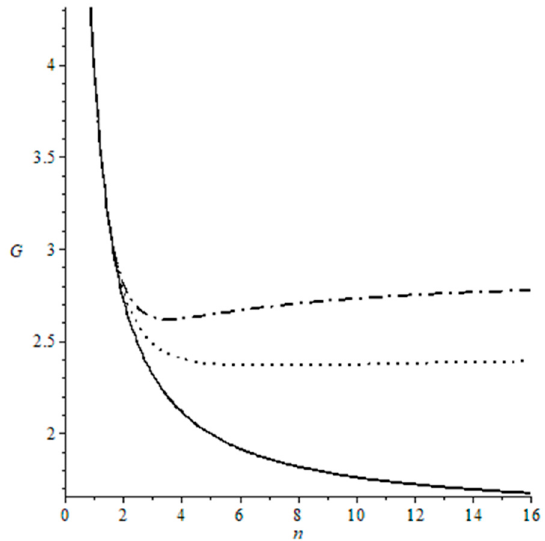
Figure 2. The growth factor depending on the number of oligopolists in a market. The growth factors differ regarding the value of B : solid line B = 2, dotted line B = 1, dash-dot line B = 0.04.